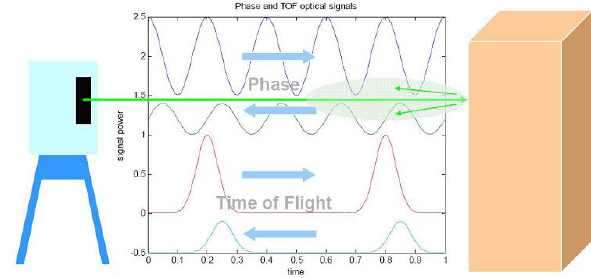
Figure 1: Working principle of phase based and time-of-flight laser scanners (Image courtesy of the UC Davis AHMCT Research Center: http://www.ahmct.ucdavis.edu)